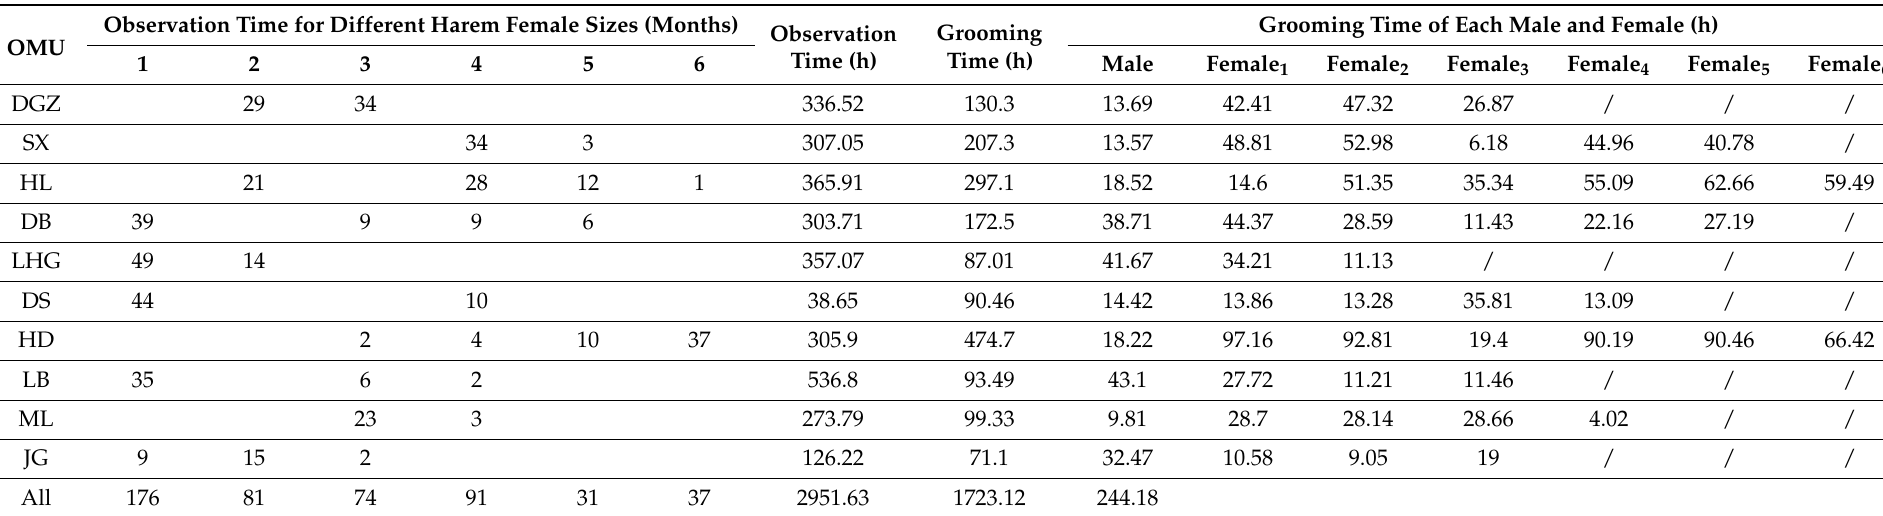
The abbreviations in the first row of the table indicate the name of